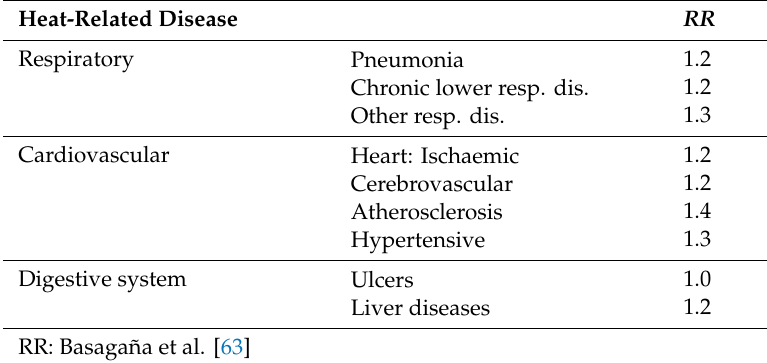
Table 3. Heat-related diseases (Unit: